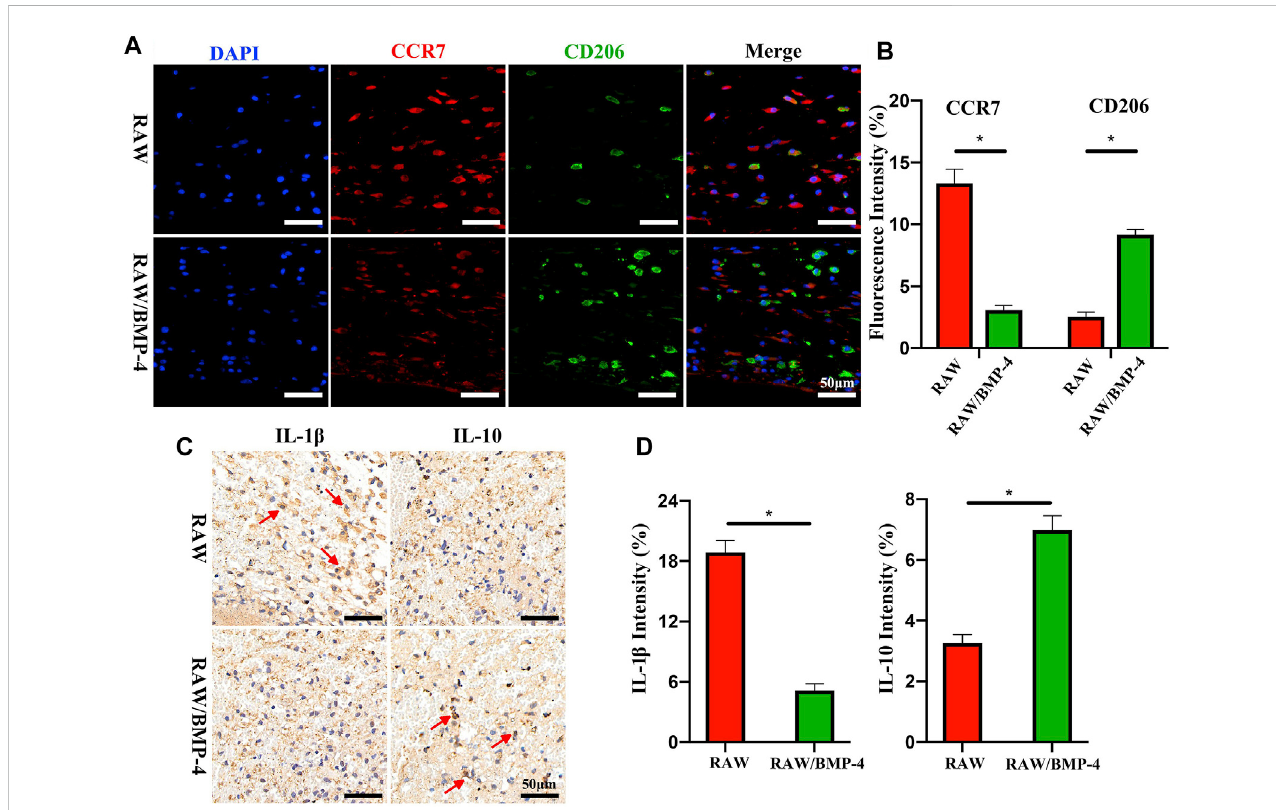
FIGURE 6 FluorescencestainingofDAPIandcellsexpressingCCR7orCD206 (A) .QuantitativeanalysisofCCR7orCD206 (B) .ImmunohistochemicalstainingofIL- 1 β and IL-10 (C) . Quantitative analysis of IL-1 β and IL-10 (D) . * p < 0.05. Reproduced with permission from (Sun et al.,